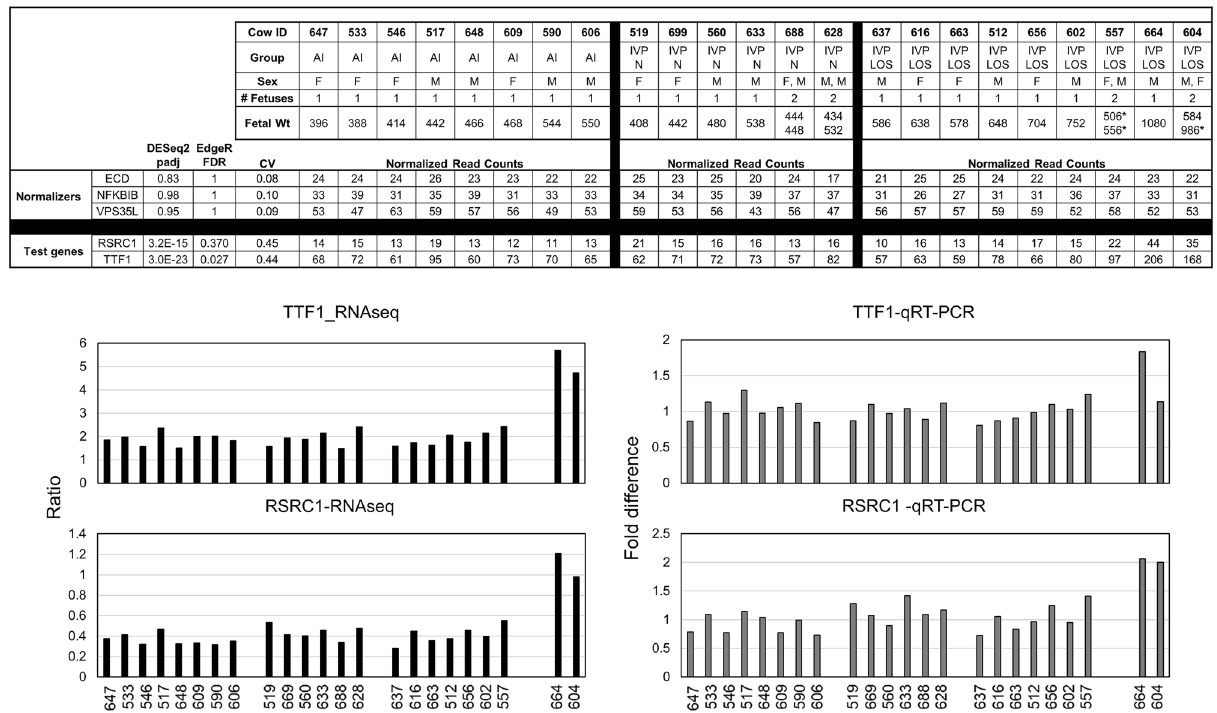
Figure 8. qRT-PCR corroborations of genes identified as differentially expressed in dams carrying the two largest LOS fetuses on D105 gestation. Top Table showing all information pertaining the samples for the genes chosen from the transcriptome for qRT-PCR corroborations. Three transcripts, namely ECD , NFKBIB and VPS35L were chosen as normalizers as their coefficient of variation (CV) across all 23 samples was ≤ .10. Test genes chosen were TTF1 (identified as differentially expressed by DESeq2 statistical software) and RSRC1 (identified as differentially expressed by DESeq2 and EdgeR statistical software packages). The table is organized by total fetal mass in increasing order. # of fetuses indicates how many fetuses the dam was carrying at the time of collection. F female fetus, M male fetus, AI artificial insemination (i.e. control). IVP-N embryos were produced by in vitro procedures that were < 97% of the control’s weight at D105. Asterisk—denotes the LOS of the pair. Bottom Bar graphs showing RNAseq results represented as sample ratio of the named gene from the mean of the three normalizers and qRT-PCR results represented as fold difference. For qRT-PCR, the geometric mean of three endogenous transcripts, namely ECD , NFKBIB and VPS35L were used to normalize the levels of TTF1 and RSRC1 . Data are represented as fold difference from the average of 21 samples (average fold difference = 1; not including 604 and 664). Transcripts of TTF1 and RSRC1 for 604 and 664 were compared to the normalized average of 21 samples for each test gene (ΔΔC T